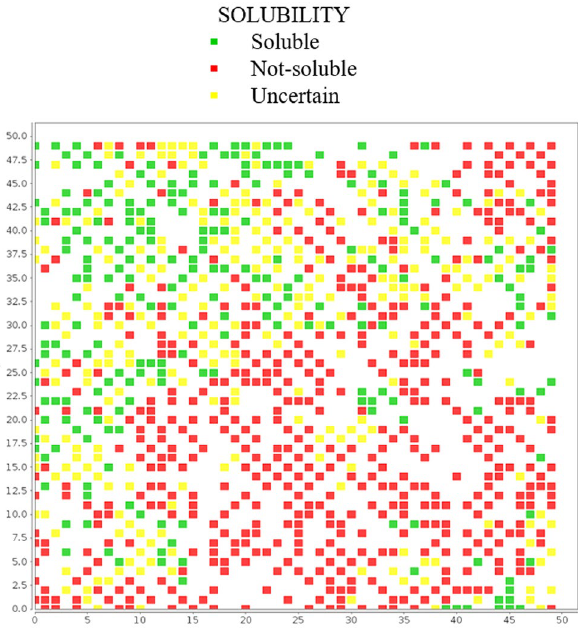
Figure 8. Region of the ADME-Space coloured by